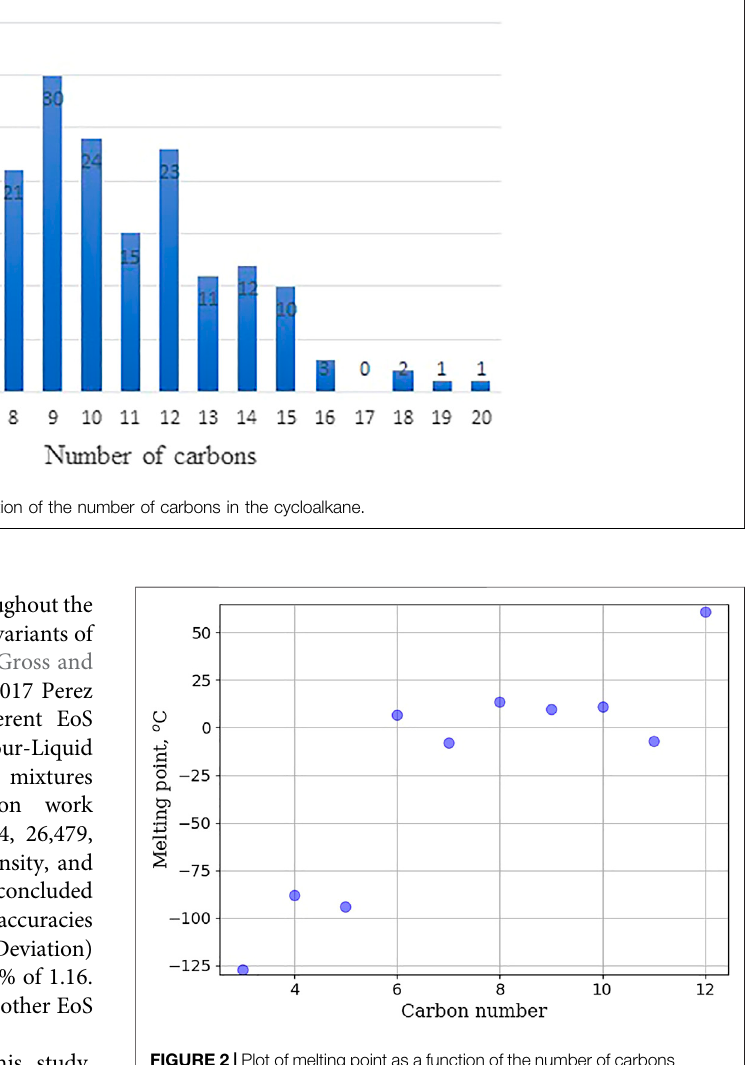
FIGURE 2 | Plot of melting point as a function of the number of carbons in the ring of the cycloalkane. Melting point of unsubstituted cycloalkanes do not increase linearly, but rather reach a plateau between cyclohexane and cyclodecane before increasing to 61 °